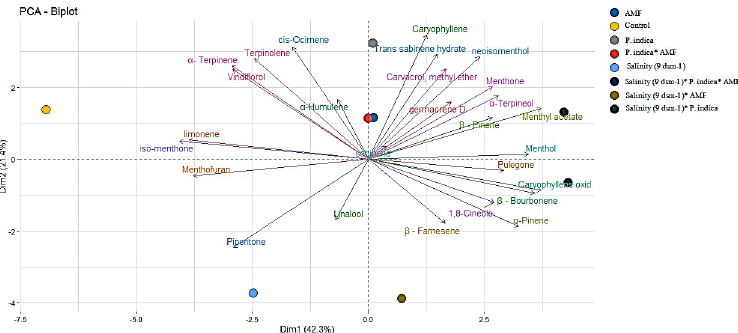
Fig 9. Principal Component Analysis (PCA) of metabolites in peppermint leaves. AMF–Mycorrhizae